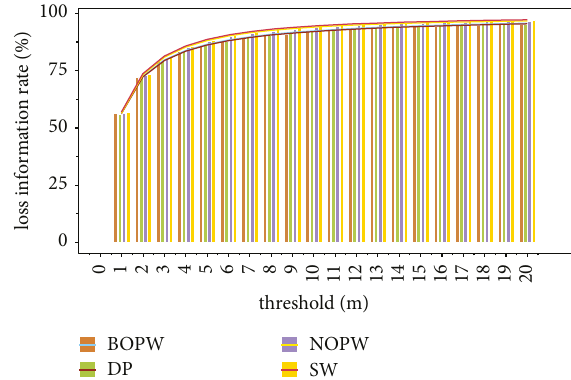
Figure 7: Redundant information rejection rate comparison of different